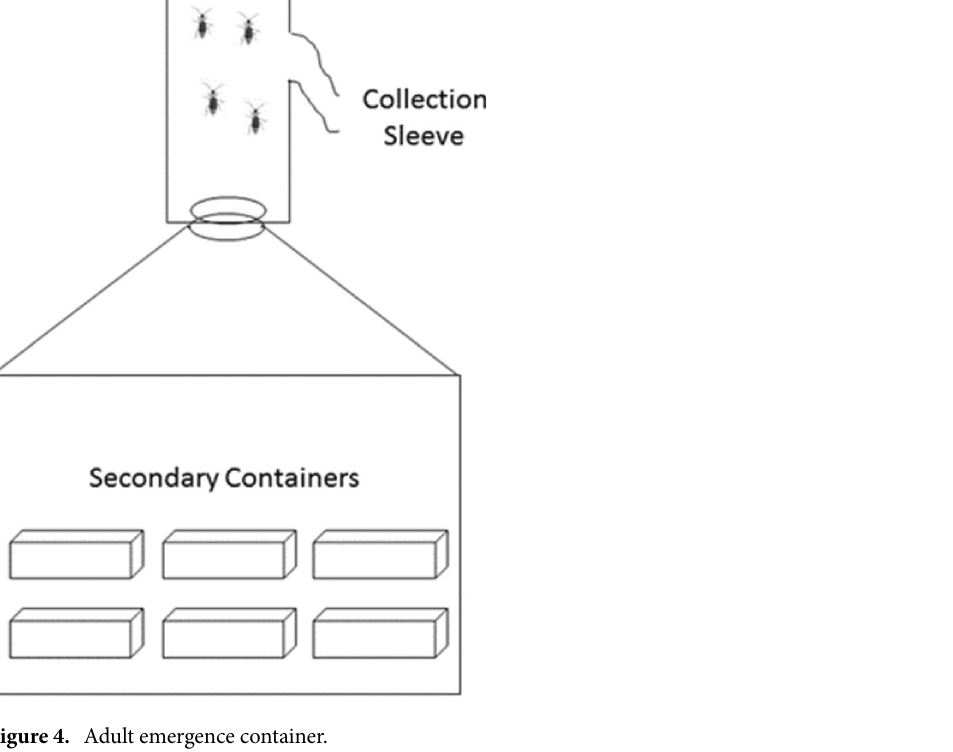
Figure 4. Adult emergence